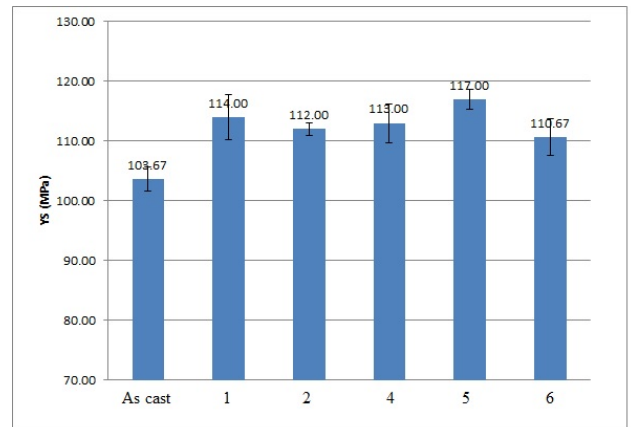
Figure 4. Results of yield strength (YS) measurements performed on 356 Al alloy: 1—after vibration by 100 Hz; 2—after vibration by 150 Hz; 4—after modification by ultrafine powder modifier; 5—after modification by ultrafine powder modifier followed by 100 Hz vibration; 6—after modification by ultrafine powder modifier followed by 150 Hz vibration; As cast—unmodified and untreated